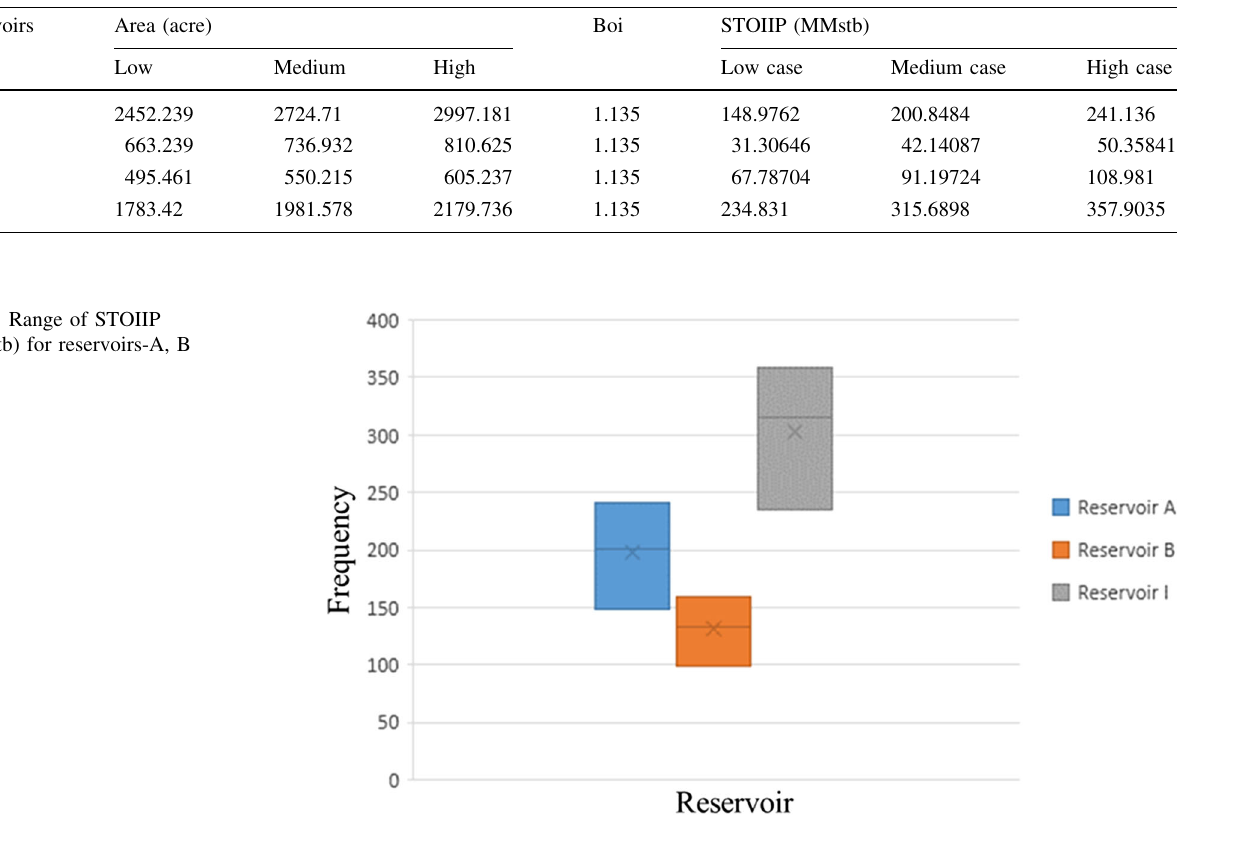
Table 3 Volume of hydrocarbon in place of the reservoirs Reservoirs